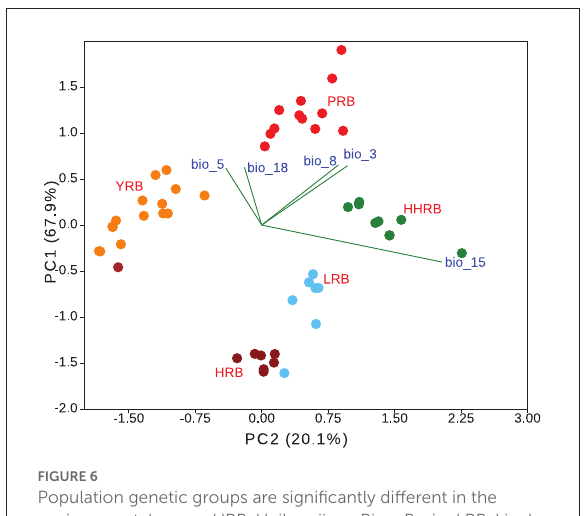
FIGURE6 Population genetic groups are significantly different in the environmental space. HRB, Heilongjiang River Basin; LRB, Liaohe River Basin; HHRB, Huanghe River Basin; YRB, Yangtze River Basin; PRB, Pearl River